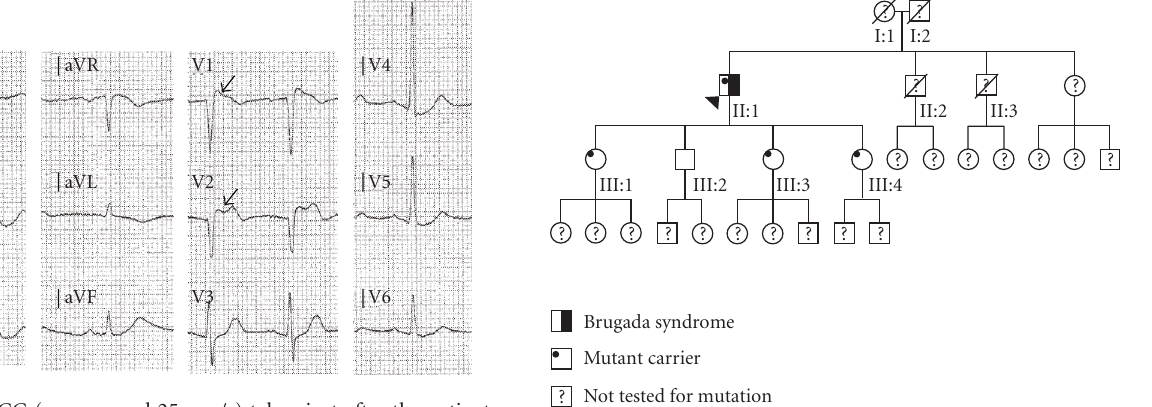
Figure 2: The family pedigree: the proband (II:1) is marked with an